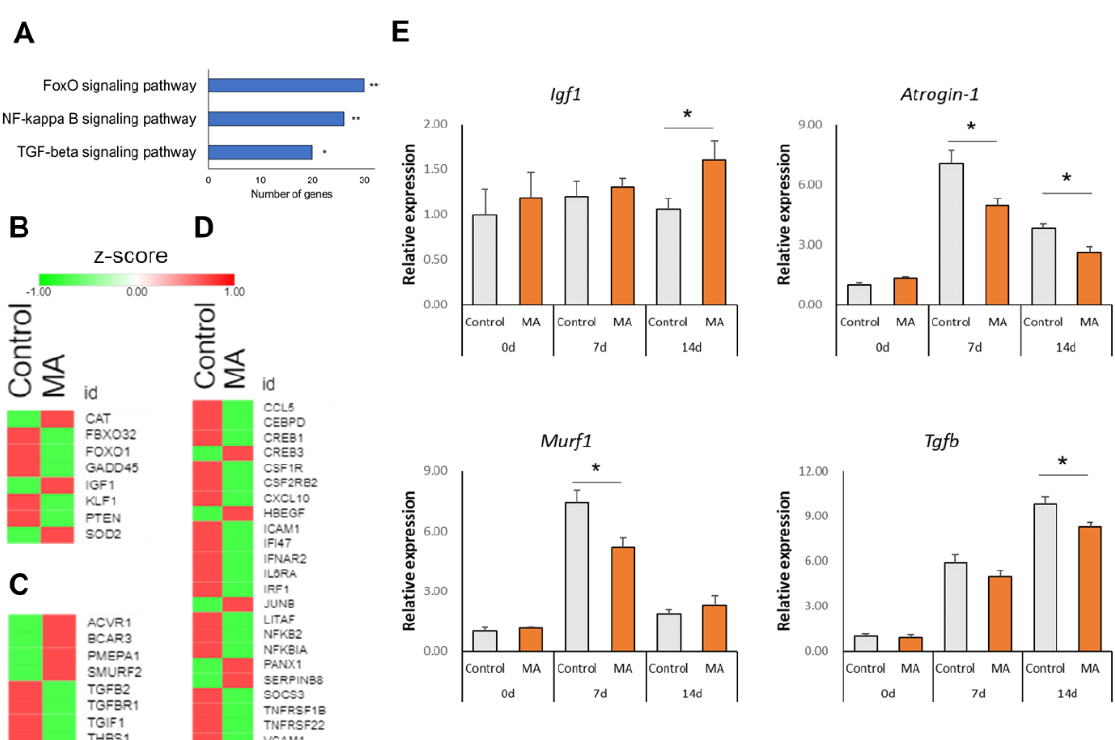
Figure 3. Changes in muscle protein degradation-related factors. ( A ) Bar graph showing significantly enriched selected KEGG pathways. Heat maps showing row z-score of DEGs involved in ( B ) FoxO signaling, ( C ) TGF- β signaling, and inflammatory response ( D ). ( E ) Relative mRNA expression levels of Igf1 , Atrogin-1 , Murf1 , and Tgfb by qPCR analysis. Data are shown as mean ± SEM ( n = 3 – 6), * p < 0.05 , ** p < 0.01 vs. control.